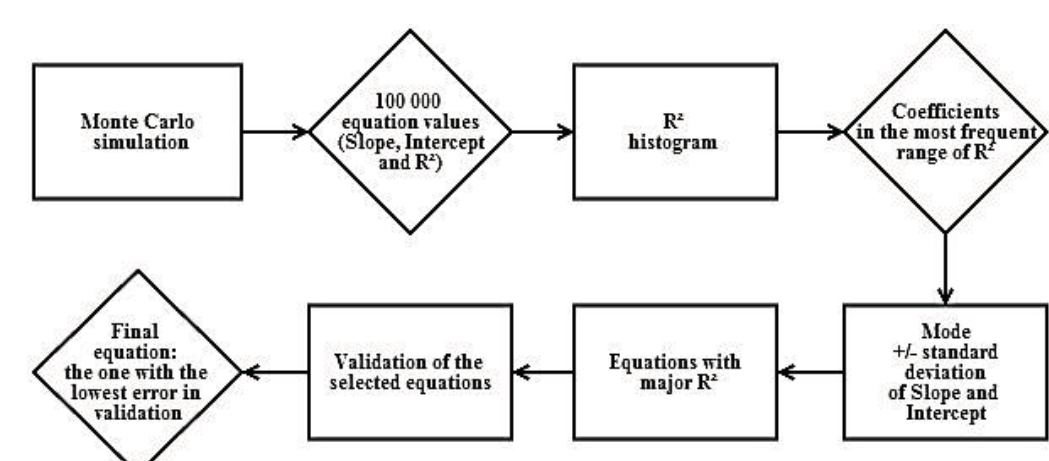
Figure 4. Calibration/validation